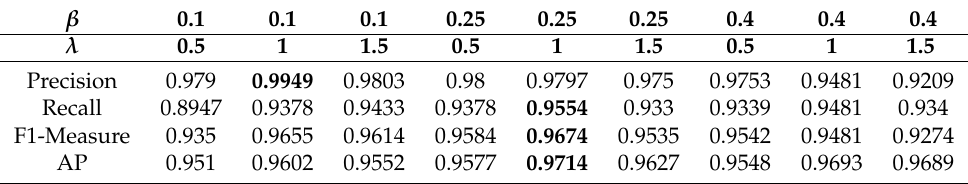
Table 1. Network performance on validation set according to different β and λ